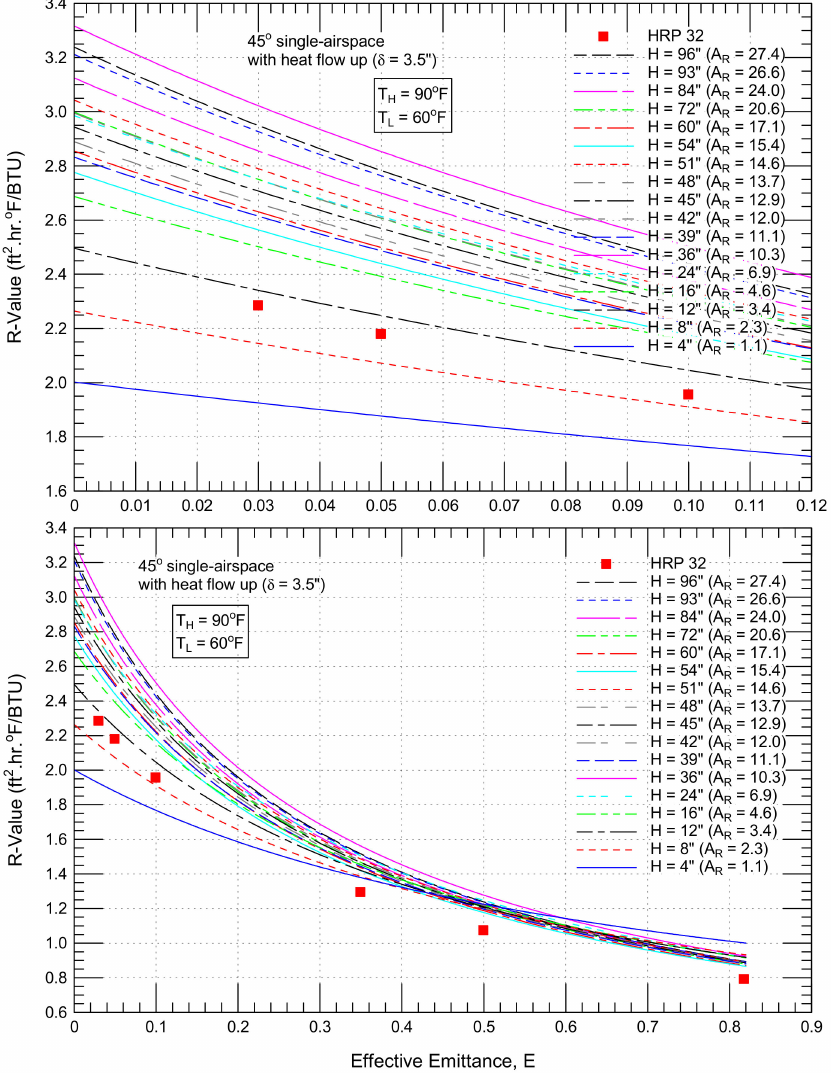
Figure 18. Comparisons of R values of HRP 32 [4] with present model predictions of various A R for a sloped single airspace subjected to an upward heat flow ( θ = 45 ◦ , total δ = 3.5 inches, T H = 90 ◦ F, T L = 60 ◦